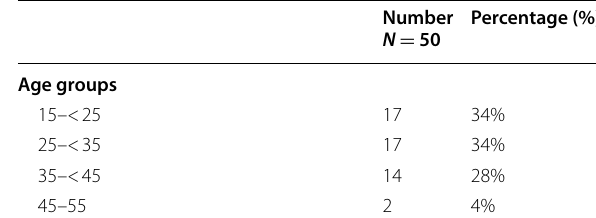
Table 1 Epidemiological characteristics of the 50 studied abusers of synthetic